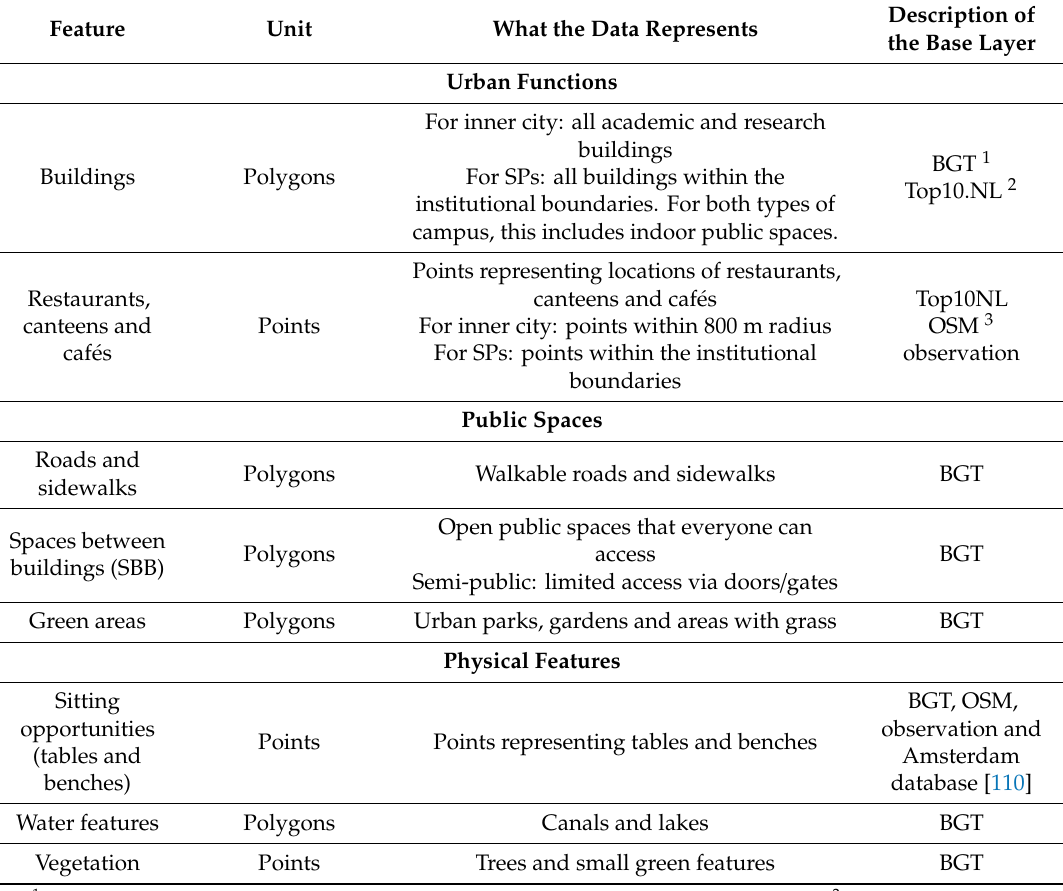
Table 3. Characteristics of the built